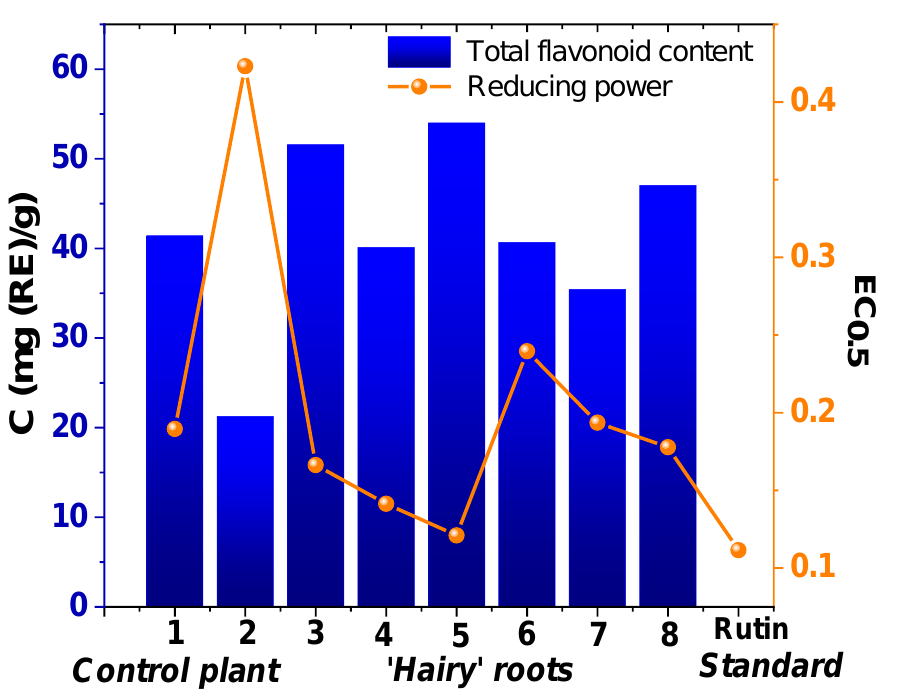
Figure 2. Total flavonoid content and reducing power of ethanolic extracts of Artemisia tilesii control plant (leaves and roots) and “hairy” root lines.